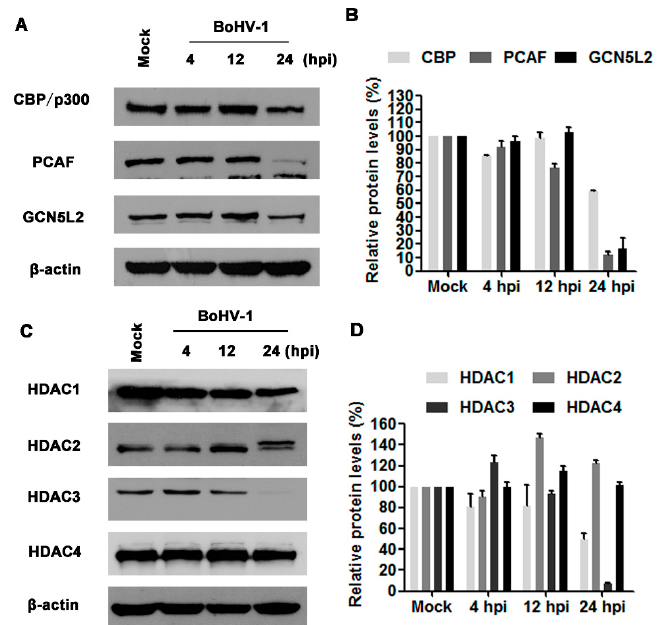
Figure 2. The effects of BoHV-1 infection on the expression of HATs (histone acetyltransferase) and HDACs (histone deacetylases). ( A ) MDBK cells in 60 mm dishes were mock infected or infected with BoHV-1 at an MOI of 1 for 4, 12 and 24 h. The cell lysates were then prepared for Western blots to detect (CREB binding protein and p300), GCN5L2 (general control of amino acid synthesis yeast homolog like 2) and PCAF (P300/CBP-associated factor). Data shown are representative of three independent experiments. ( B , D ) The relative band intensity was analyzed with software image J, and each analysis was compared with that of uninfected control which was arbitrarily set as 100%. The error bars denote the variability between the three independent experiments. ( C ) MDBK cells in 60 mm dishes were infected with BoHV-1 at an MOI of 1 for 4, 12 and 24 h. The cell lysates were then prepared for Western blots to detect HDAC1, HDAC2, HDAC3 and HDAC4. Data shown are representative of three independent